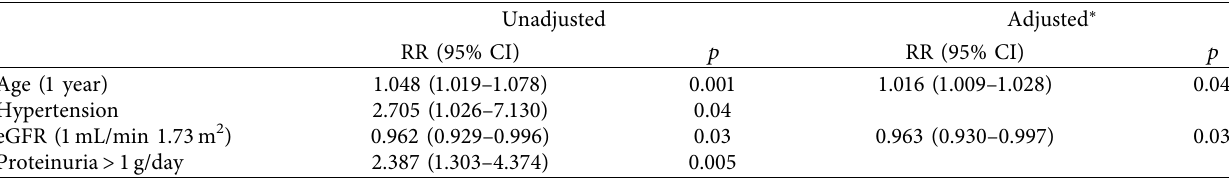
Figure 1: Prevalence of subclinical hypothyroidism according to the CKD Table 2: Logistic regression analyses for variables associated with subclinical hypothyroidism.